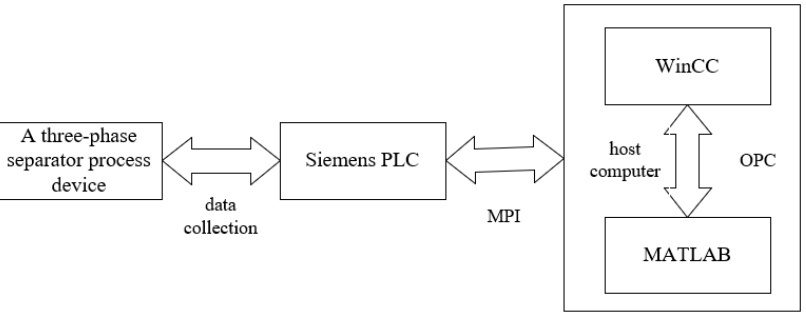
Figure 4. Control system